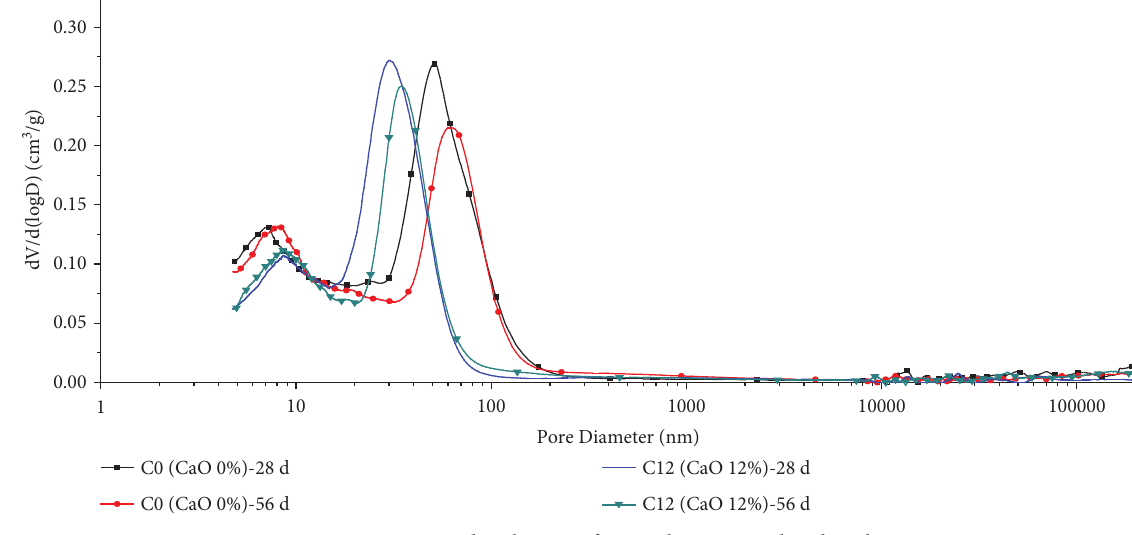
Figure 2: Pore size distribution of C0 and C12 at 28d and 56 d. Table 6: Total porosity, pore size distribution, and average pore diameter of C0 and C12 at 28d and 56d. Group